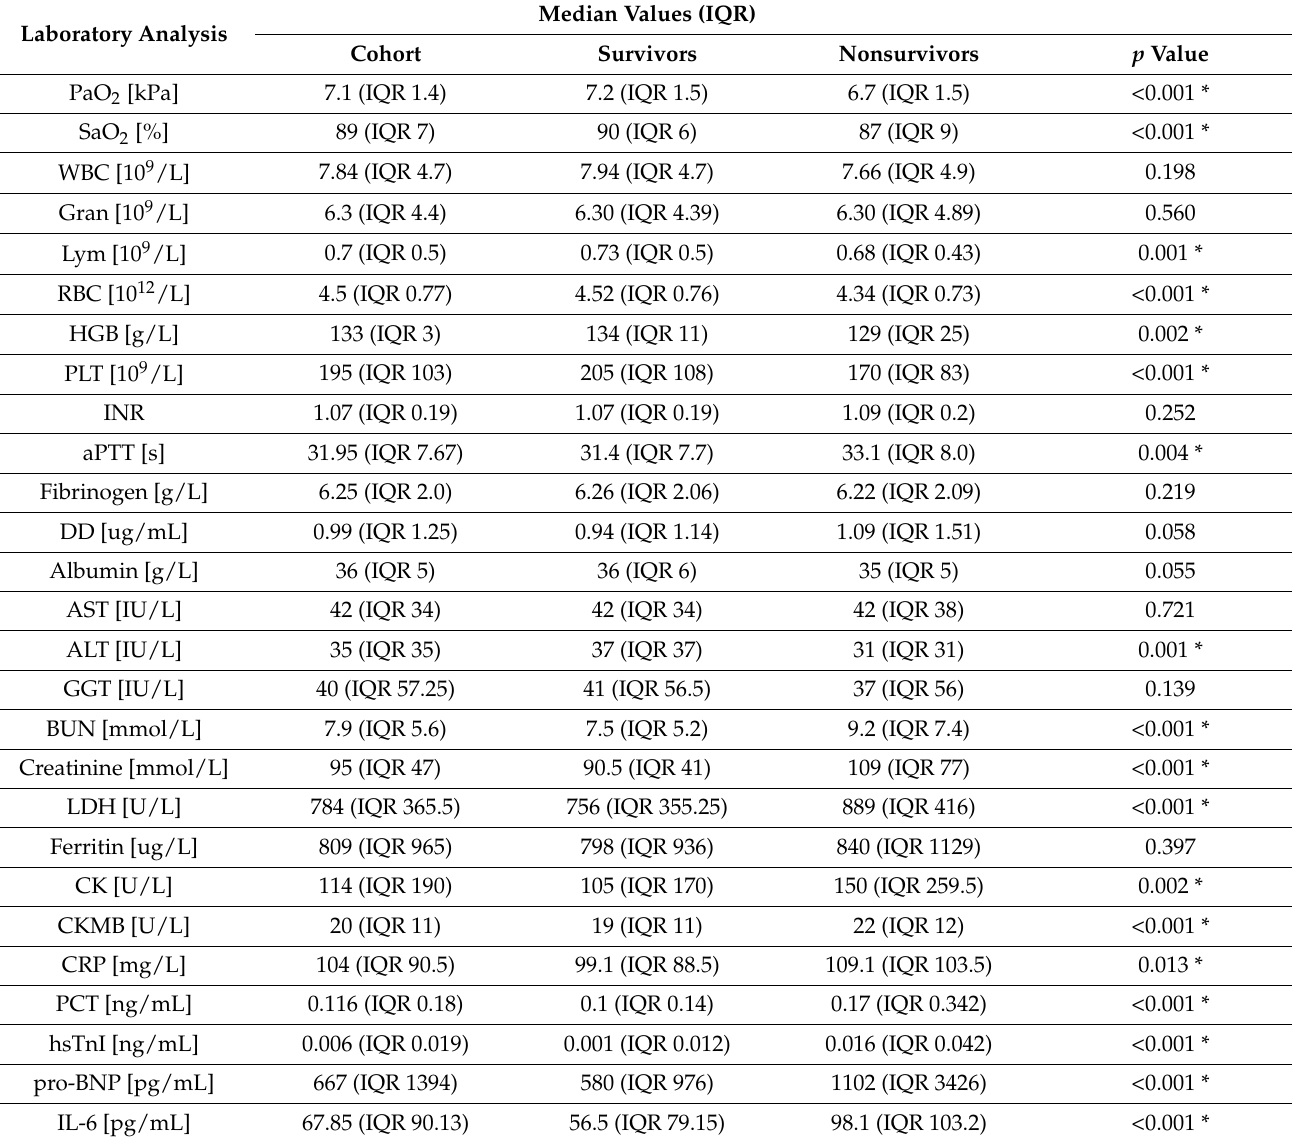
Table 2. Admission blood gas and laboratory analysis of COVID-19 survivors and